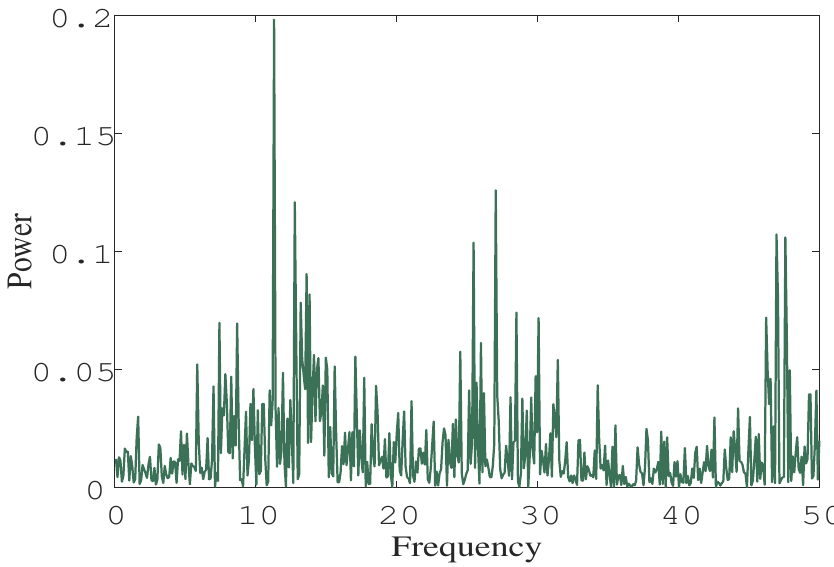
Figure 2. Continuous broadband power spectrum of the new chaotic system for ( a , b , c , k ) = ( 12,100,10,4.6 ) .